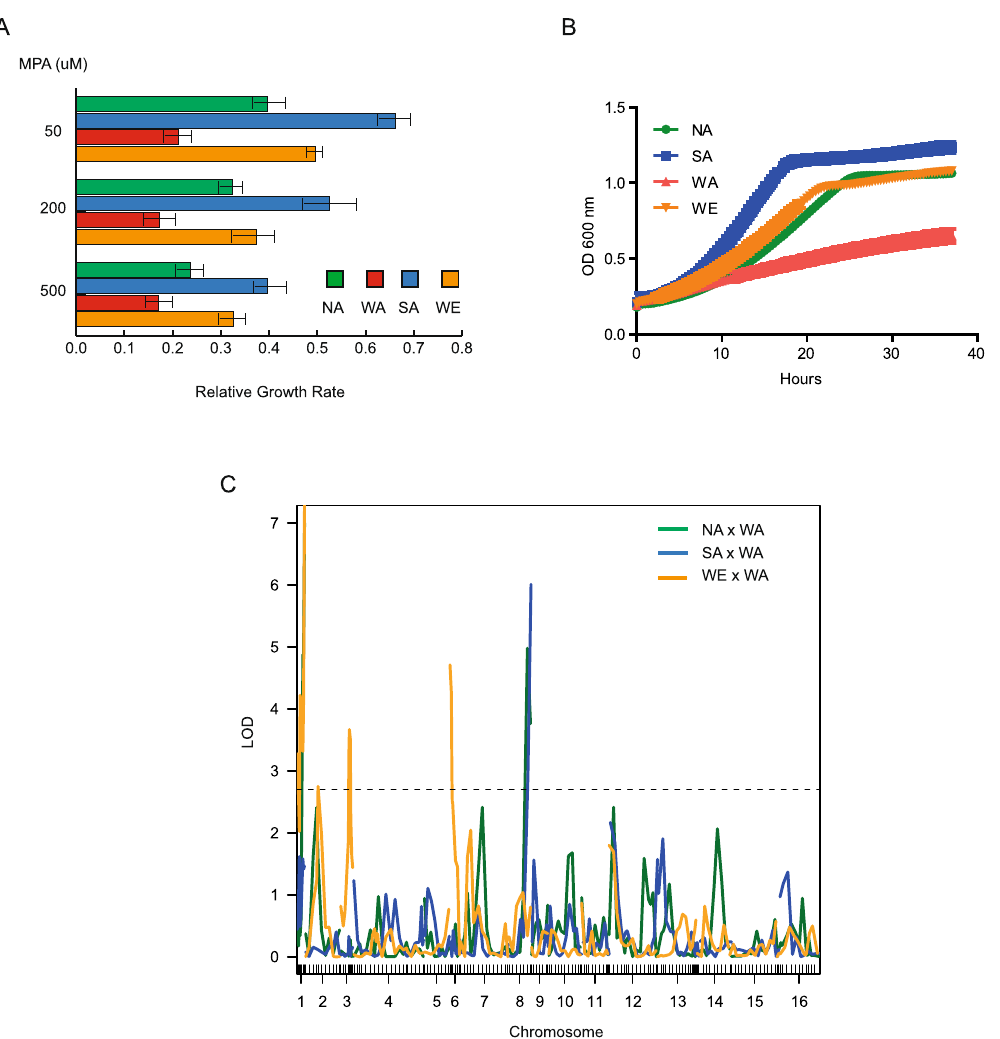
Figure 1. Growth rates of S. cerevisiae isolates subjected to MPA. ( A ) Relative growth rates (MPA/YPD) for the North American (NA), West African (WA), Sake (SA), and Wine/European (WE) isolates. ( B ) Growth data for the microcultivation of four isolates grown in 200 μ M MPA. ( C ) LOD plot for linkage analysis for the NA × WA (green), SA × WA (blue) and WE × WA (orange) crosses. Dotted line represents the highest LOD cut-off scores (LOD = 2.73) among the three crosses. FDR = 0.05 was used to determine